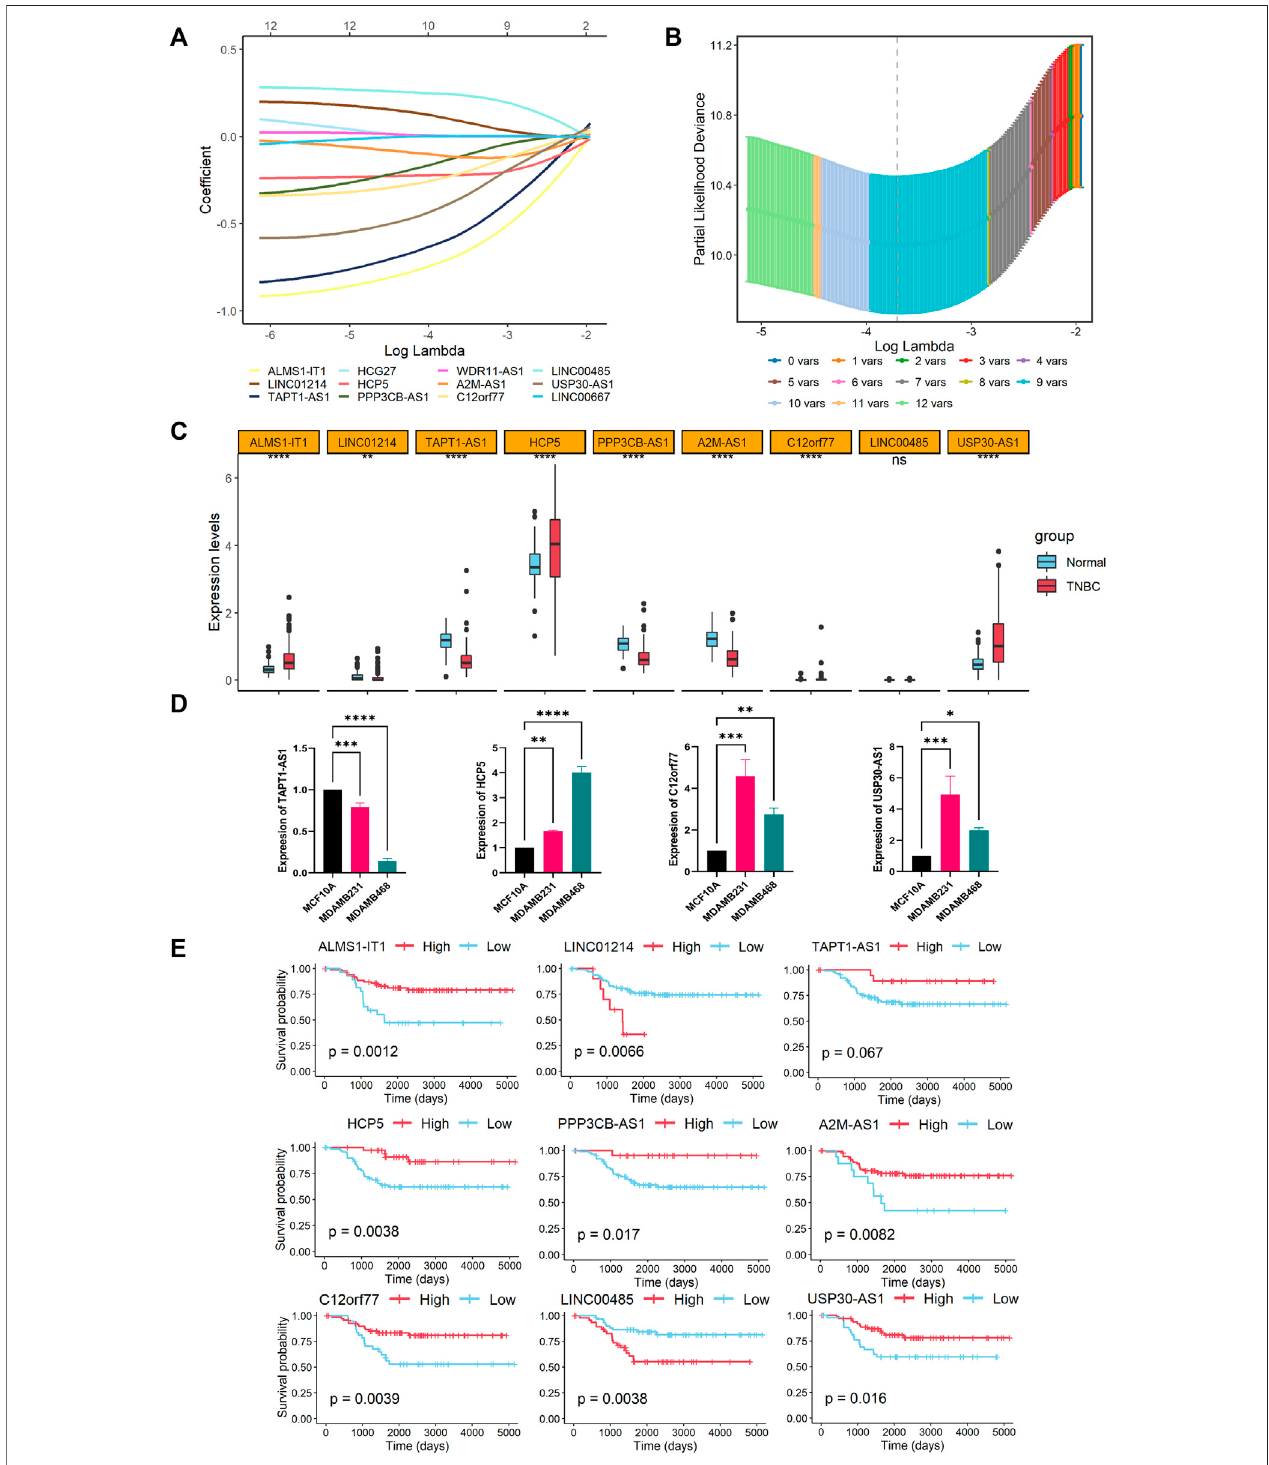
FIGURE 3 | Construction of a necroptosis-related lncRNAs signature. (A) LASSO coef fi cient pro fi les of the nine model lncRNAs in the training cohort. (B) A coef fi cient pro fi leplotoftheLASSOmodelwasproduced against thelog(lambda) sequence and toscreentheoptimal parameter atwhichthevertical linesweredrawn. (C) Expression pro fi les of nine model lncRNAs between the tumor and normal samples shown as boxplots (****, **, and ns indicate p < 0.0001, < 0.01, and no signi fi cance, respectively). (D) Relative expression levels of TAPT1-AS1, HCP5, C12orf77, and USP30-AS1 in MCF10A, MDA-MB-231, and MDA-MB-468 cell lines ( n = 3; ****, ***, **, and * indicate p < 0.0001, < 0.001, < 0.01, and < 0.05, respectively). (E) Overall survival curves based on high and low expression levels of each model lncRNA.